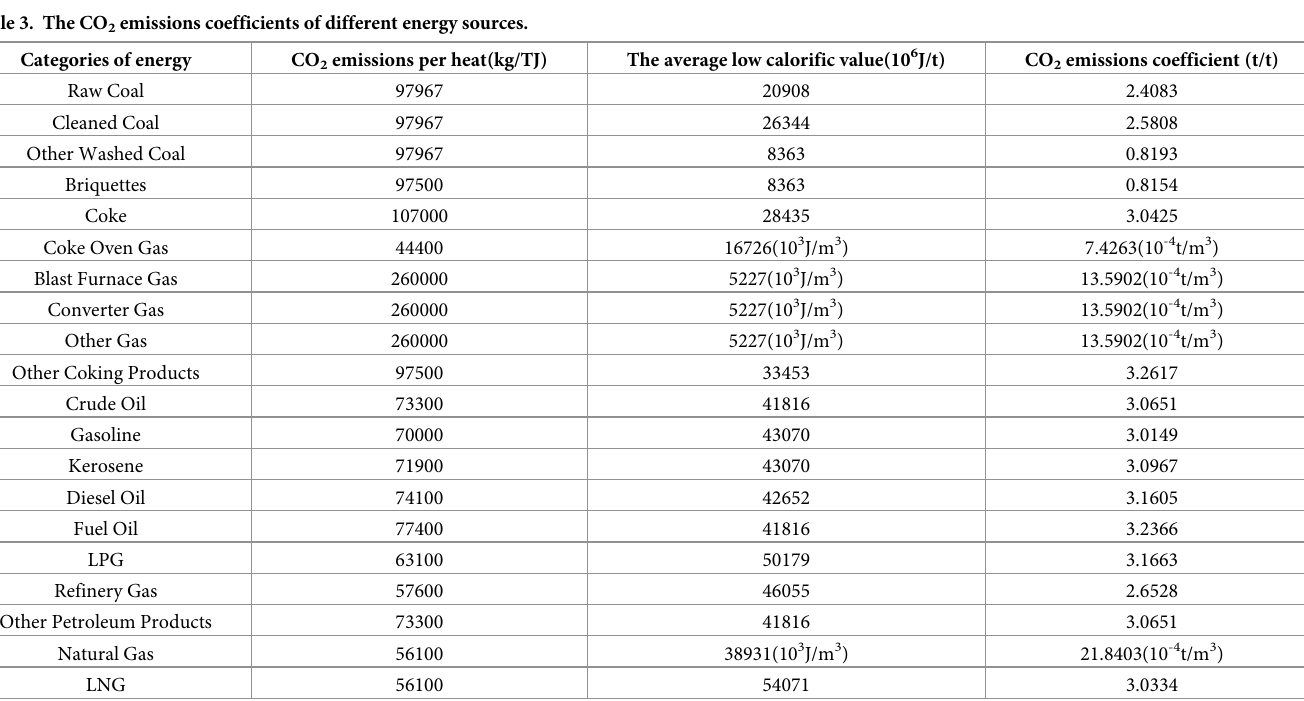
Table 3. The CO 2 emissions coefficients of different energy